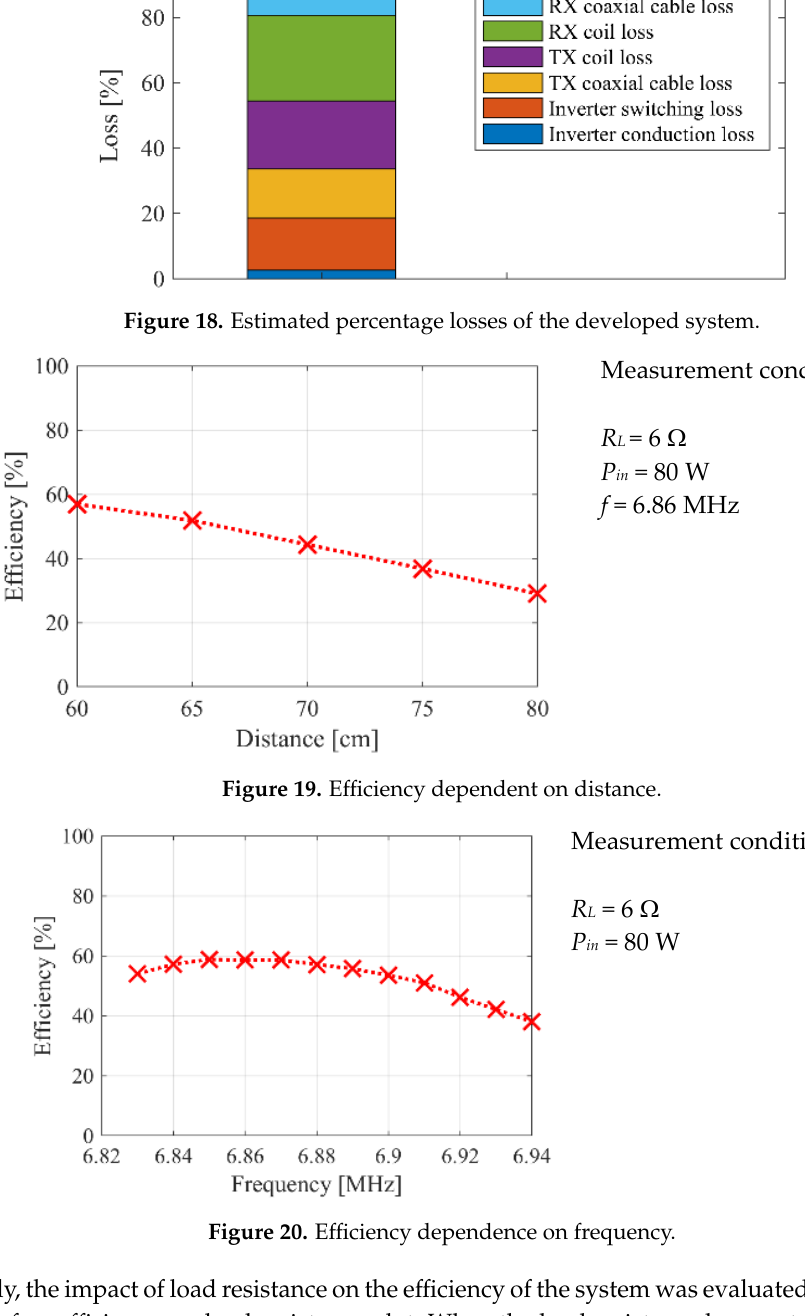
Figure 21. Efficiency dependence on load resistance. 7. Conclusions In this paper, a new 6.78-MHz, 50-W, over 60 cm wireless power transfer system is proposed. The design and fabrication methodologies for the coils, a GaN-based 6.78-MHz H-bridge inverter, and a rectifier were explained. Using a multi-objective optimization method, Pareto optimality, the transmitter and the receiver coil were determined to a 4-turn and a 5-turn, 40 cm × 40 cm square coils. The selected transmitter and receiver coils were fabricated on a PCB. It was shown that the dielectric loss of the PCB substrate can dominate Ohmic loss of copper traces at MHz frequencies. A PCB substrate with very low dissipation factor was used to reduce the dielectric loss of the coils. The fabricated coils had over 350 Q-factors at 6.78 MHz. The peak coil-to-coil efficiency for the WPT system was 77 % at 60 cm air-gap. In addition, a 6.78-MHz, 100-W, 92 % efficiency, GaN-based H-bridge inverter was developed. Two important points were considered in the development of the inverter: a low parasitic inductance of the gate drive circuit and a good heat dissipation of the GaN switch at its rated output power. Parasitic inductances between the gate drivers and GaN switches caused significant ringing of the on/off signals and poor operation performances even at sub-MHz frequencies. A close positioning of the gate driver to the switch was the key for 6.78-MHz operation. However, the